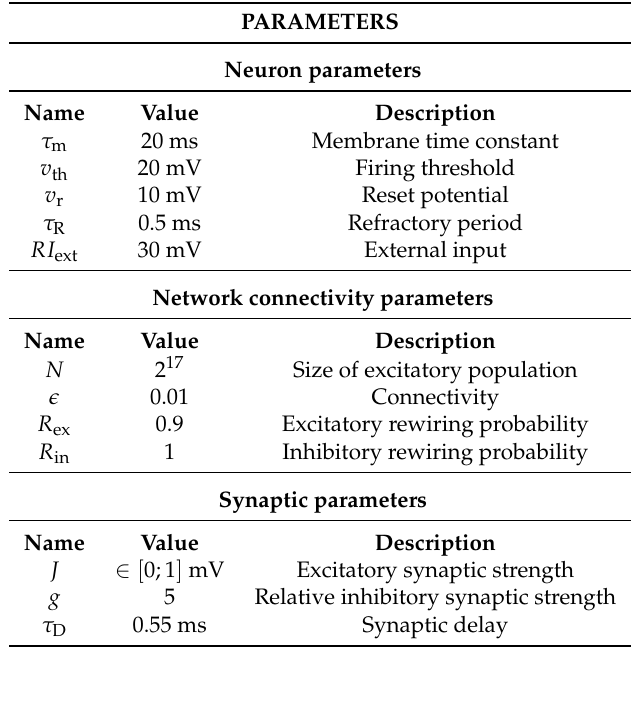
Table 1. Summary of the parameters used in this